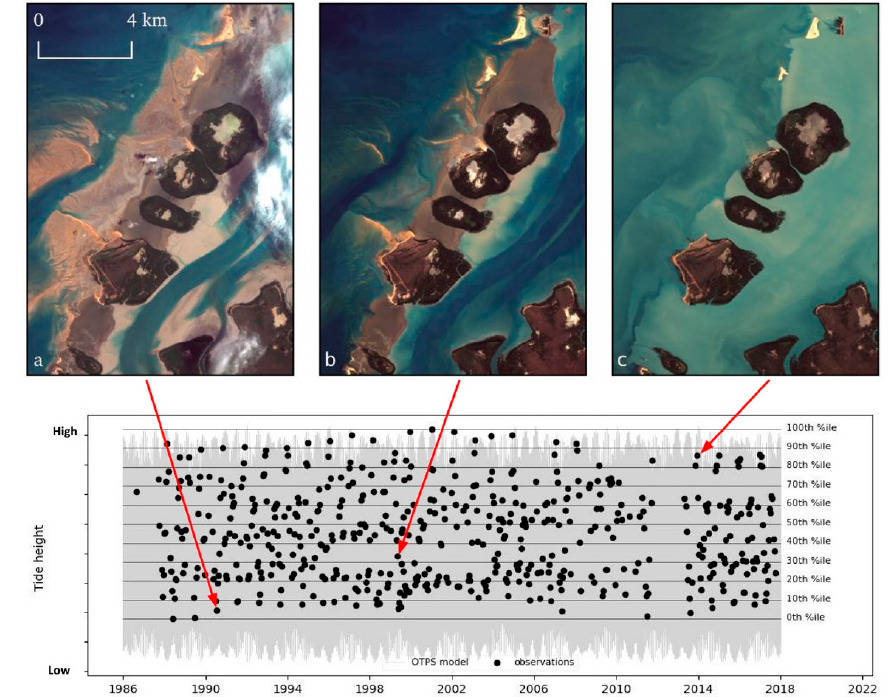
Figure 2. Tidal height attribution to observations: for a given location, the tidal model (grey) can be used to attribute a tidal height relative to mean sea level (MSL (m)) based on the date and time of the image acquisition (black). Images illustrate the manner in which the tidal height attribution can be used can characterise the environment at different biophysical states i.e., low ( a ) through mid ( b ) to high ( c ) tide. The percentile lines represent percentiles of tide height within the observed tidal range (OTR), and the range between the lowest (LOT) and highest (HOT) observed tides in the attributed observations.